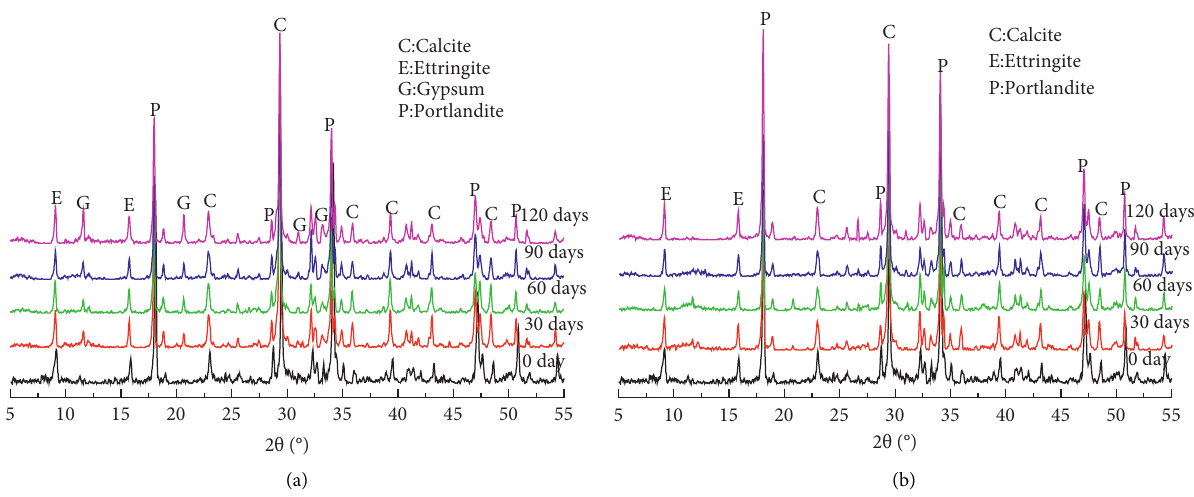
Figure 9: XRD pattern of 5% limestone powder content within 120 days. (a) Cathode surface and (b) anode surface.